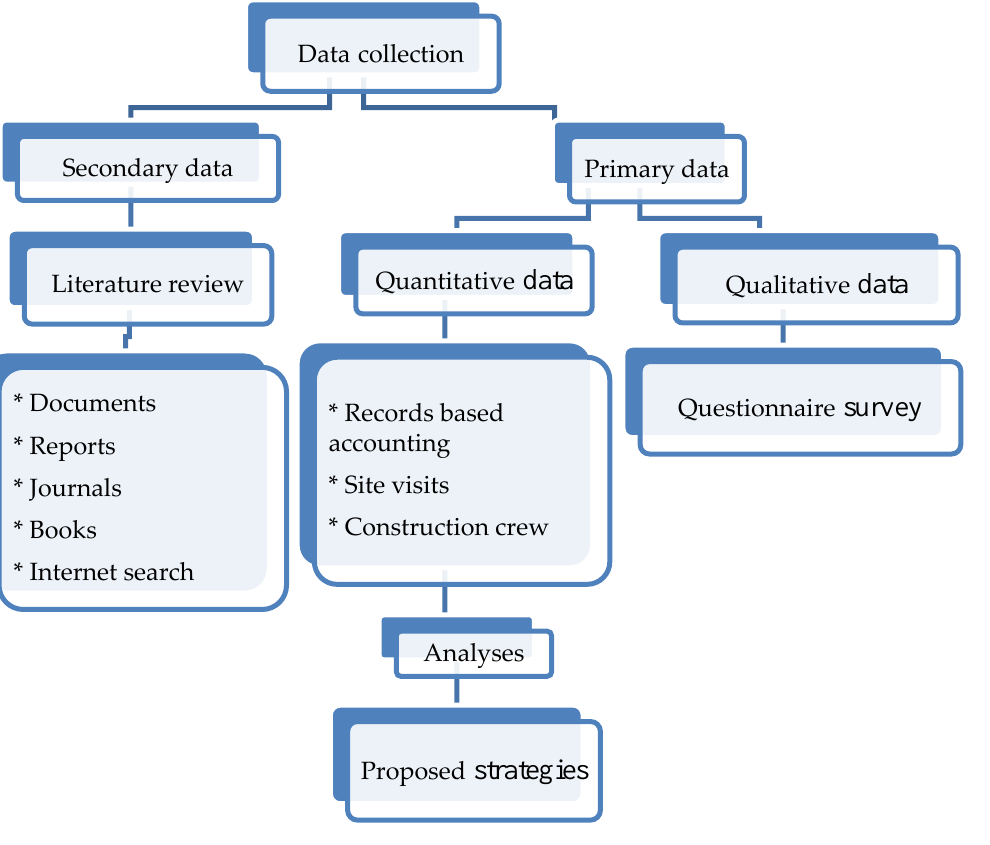
Figure 1. Flowchart of the research methodology.